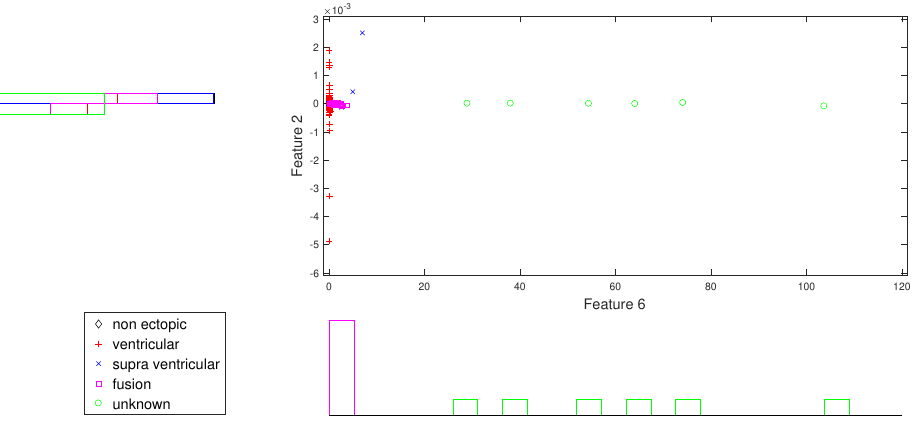
Figure 7. Scatter plot with marginal histogram for norm entropy (IMF1) vs. CUM2 (IMF1).